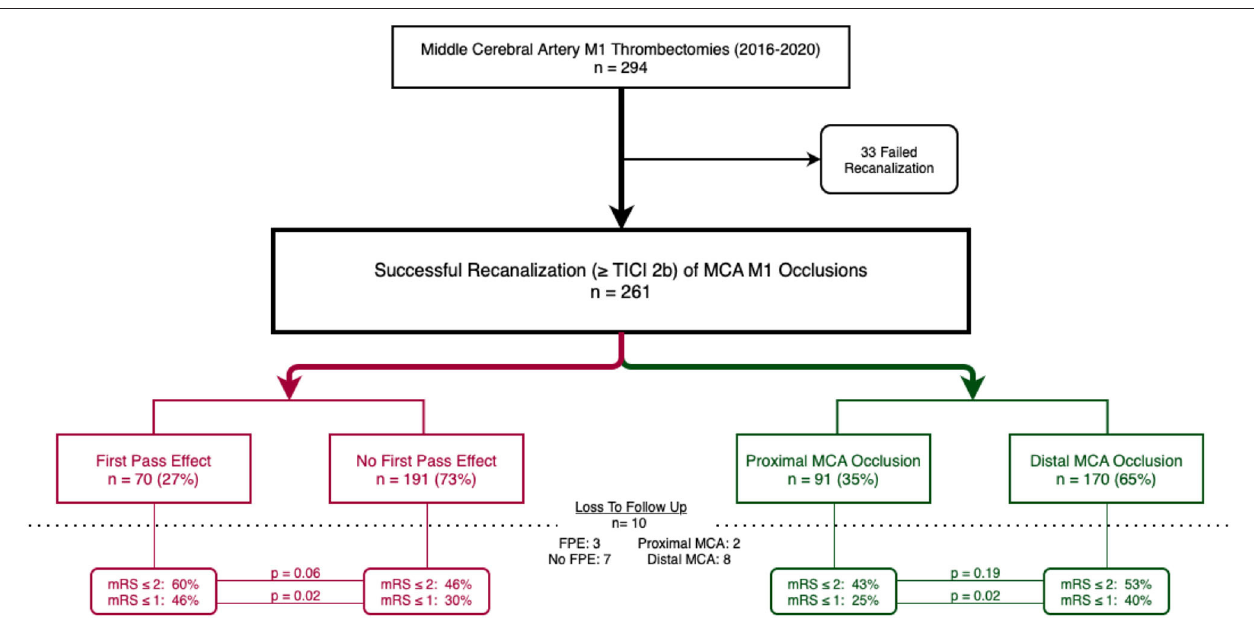
FIGURE 1 | Flow chart of patients included in the study; cohort by first pass effect in red (left) and cohort by proximal or distal MCA occlusions in green (right). Ten patients were loss to follow